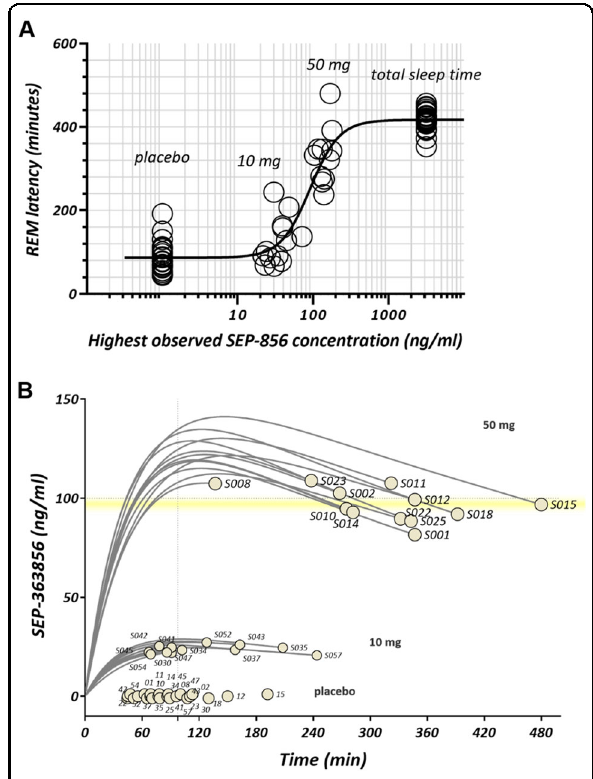
Fig. 5 Effect of SEP-363856 plasma concentration on REM parameters. A Effects of SEP-363856 concentration on the latency to REM sleep. Nonlinear regression of all subjects ’ placebo, total sleep time, and highest observed concentrations estimated half-maximal effects at 100 ng/mL. Placebo and total sleep time were assigned to minimum and maximum concentrations respectively. 95% C.I. of fi tted EC50 = 77 – 110 ng/ml. B Concentration trajectories until fi rst REM sleep episode. Circles represent the time of a labeled subjects fi rst REM sleep episode. The trajectories represent the interpolated drug concentrations prior to the fi rst REM sleep episode. Individual subject ’ s plasma samples (4 plasma samples per subject) were used together with a population-based pharmacokinetic model to interpolate trajectories for each subject shown (subject